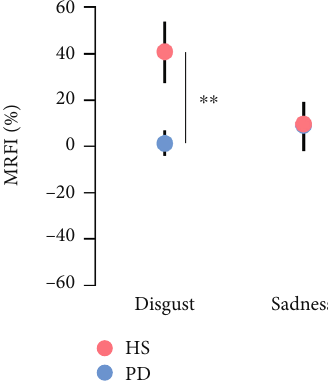
Figure 3: Motor resonance fl exibility index (MRFI) which represents the amount of in fl uence of emotional context on motor resonance calculated with the following formula: MRFI=(MEPs emotion − MEPs no-emotion/MEPs baseline) × 100 in PD patients and healthy subjects (HS). Vertical bars indicate SE.